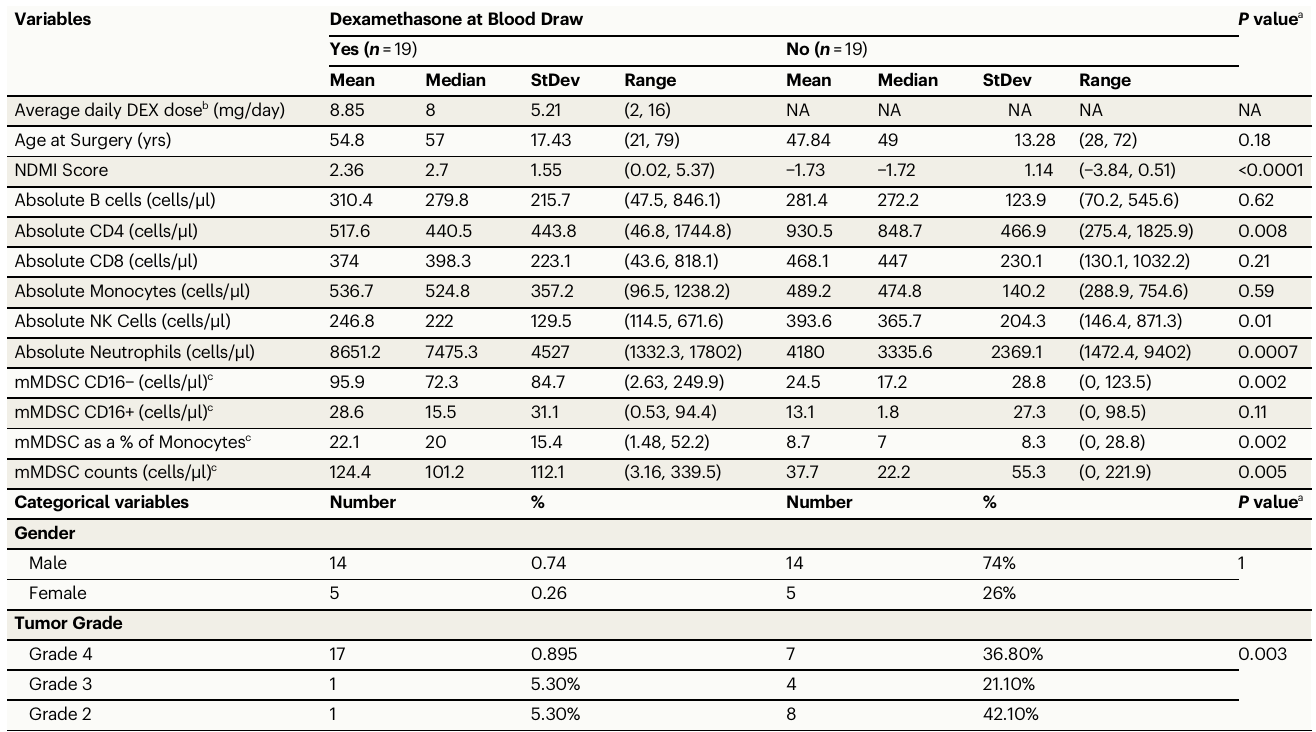
Fig. 5 | Comparison of DEX predictors in training and test datasets. a Distributions of NDMI and two other DEX predictor scores in training and test datasets. b ROC analysis comparing the performance of three predictors of DEX